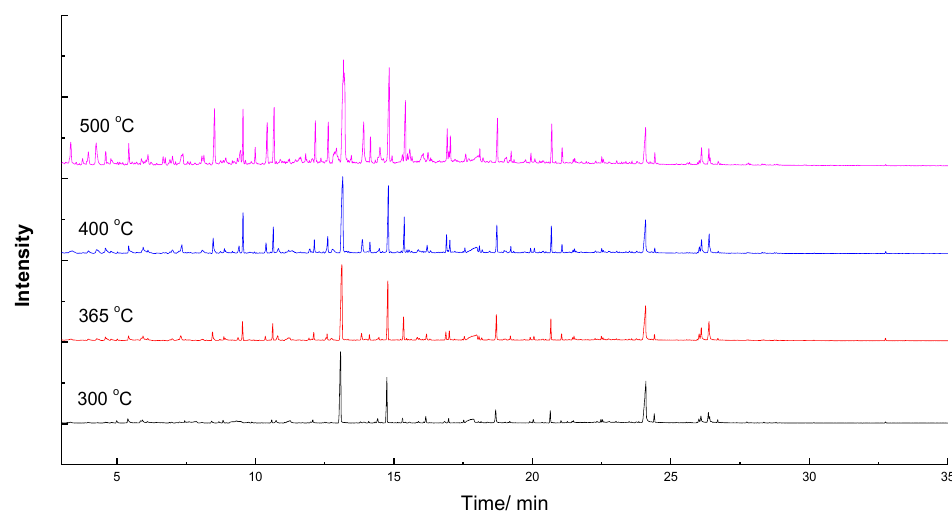
Figure 2. Gas Chromatography / Mass Spectrometry (GC/MS) diagram of EHL at different temperatures.